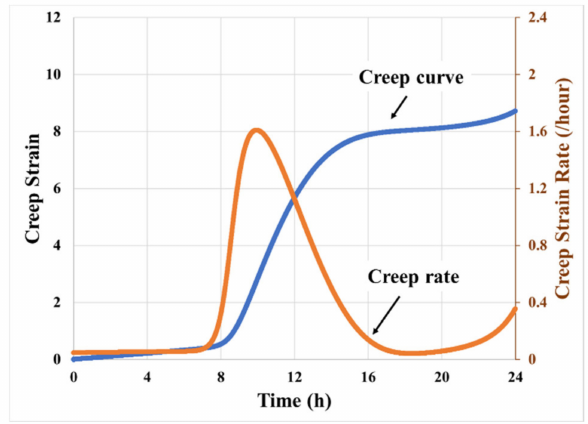
Figure 12. Model prediction of creep curve and creep rate curve of PSA bonded assembly at the stress level of 50 kPa based on the data collected in Table